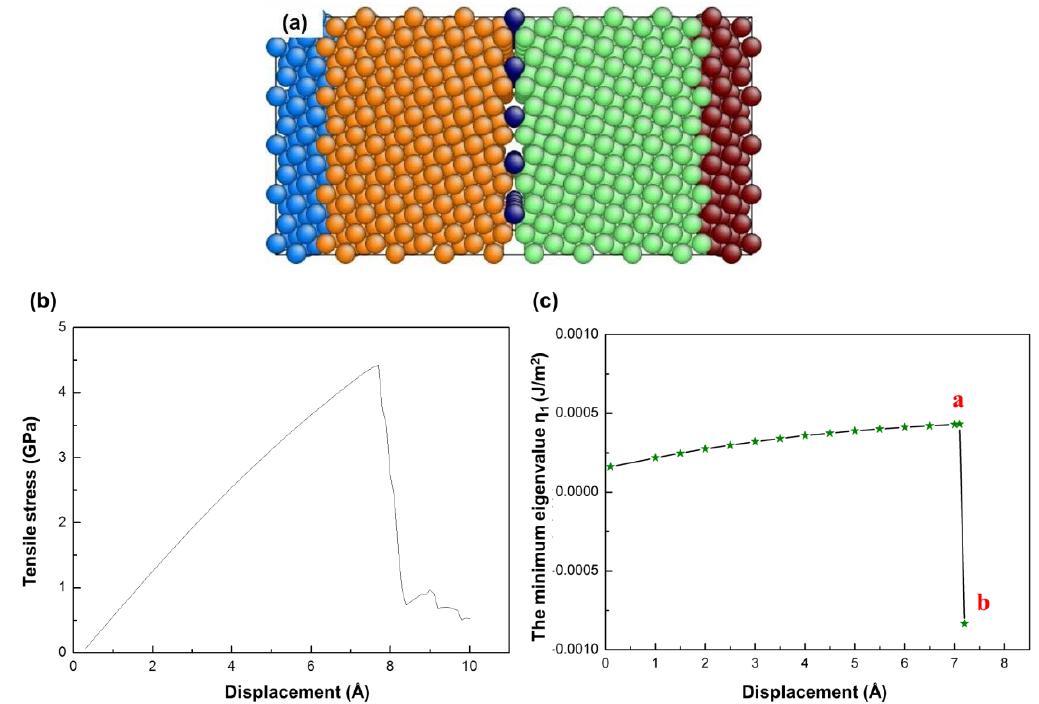
Figure 7. Atomic configuration of the simulation cell at ( a ) point A and ( b ) point B in Figure 6c. The atoms with unspecific coordination are deleted in ( b ) for a clear view of dislocation.